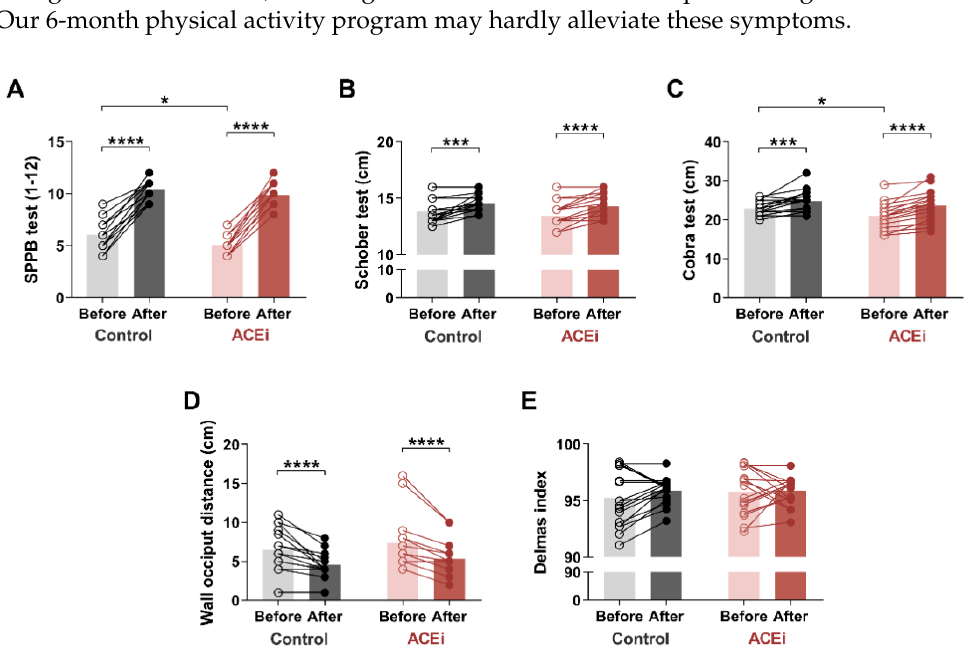
Figure 1. The effects of a 6-month functional training program on muscle mobility and posture in elderly females with sarcopenia. ( A ) Short Physical Performance Battery (SPPB) test. ( B ) Schober test. ( C ) Cobra test. ( D ) Occiput wall distance. ( E ) Delmas index. Bars show the mean, and each data point represents an individual subject. Statistically significant differences are defined as * p < 0.05; *** p < 0.001; **** p < 0.0001. Abbreviations: ACEi, angiotensin-converting enzyme inhibitors.